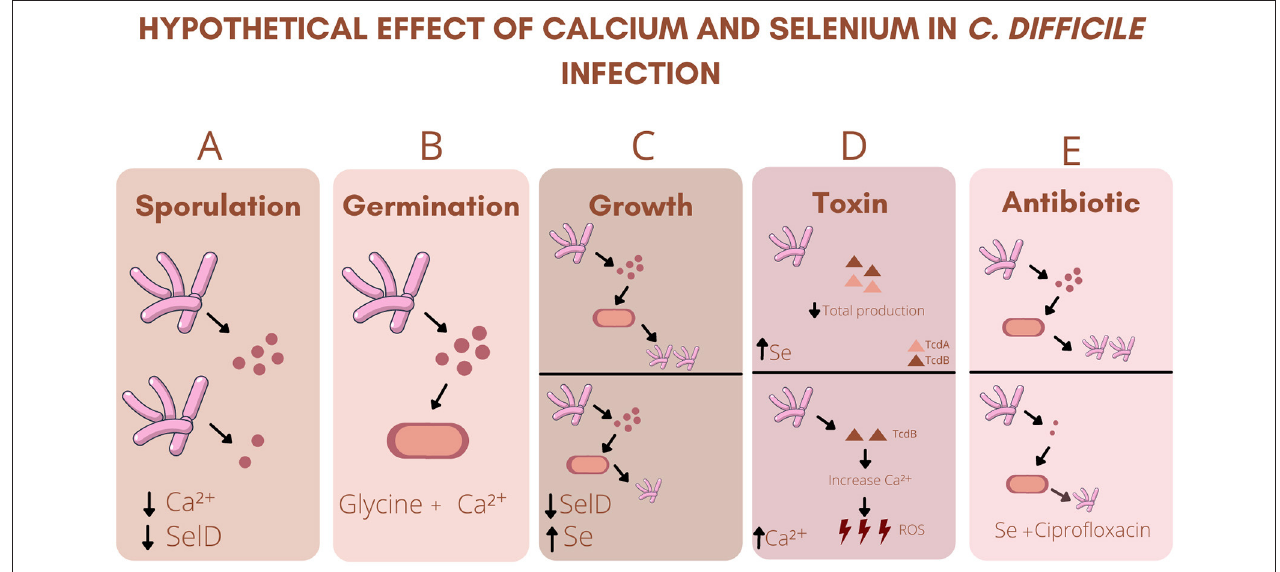
FIGURE 1 | Hypothetical effect of calcium and selenium in C. difficile infection: (A) Decreased intestinal Ca 2 + (Calcium) or SelD (Seleno phosphate synthetase) deficiency decreases spore formation. (B) Association between Ca 2 + and Glycine is essential for the initiation of germination. (C) SelD deficiency decreased the growth of C. difficile and sodium selenite (Se) inhibited the growth of the strain. (D) High levels of Se decreases the total production of TcdA ( Clostridium difficile toxin A) and TcdB ( Clostridium difficile toxin B). High levels of TcdB increases Ca 2 + levels, which in turn increases the production of ROS (Reactive oxygen species). (E) Association of Se with ciprofloxacin decreases the growth of C. difficile, as well as its sporulation.